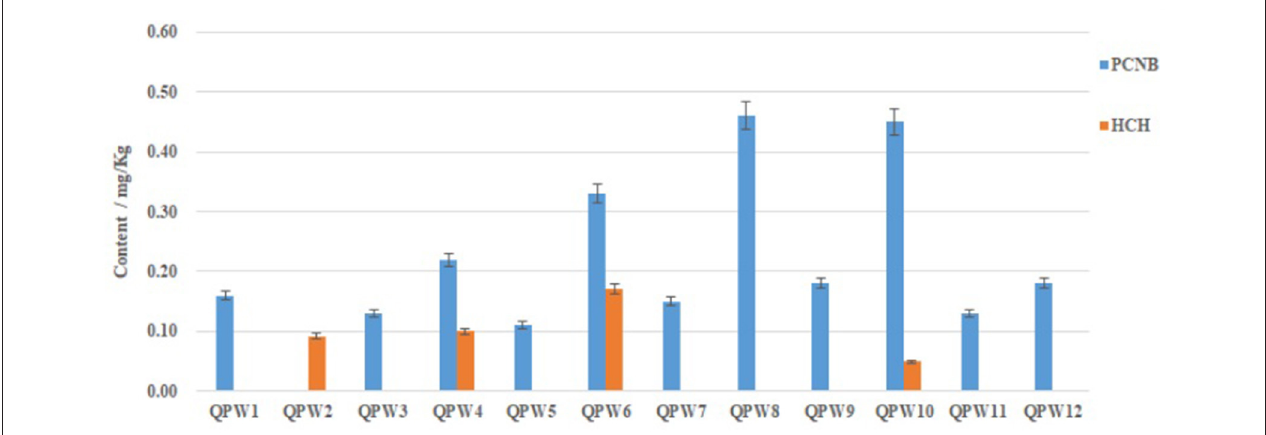
FIGURE 4 | Contents of pesticide residues in Qipi pills. DDT and Aldrin were not detected in all the 12 CPM